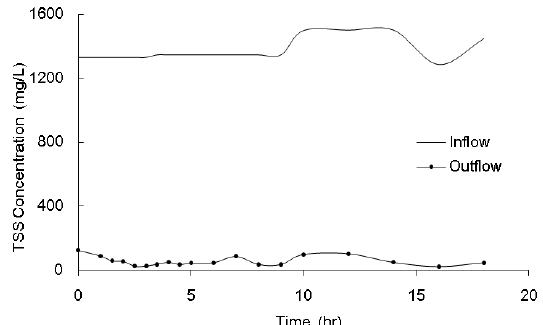
Figure 4. K /K0 vs. operation time (Exp. No.E9).